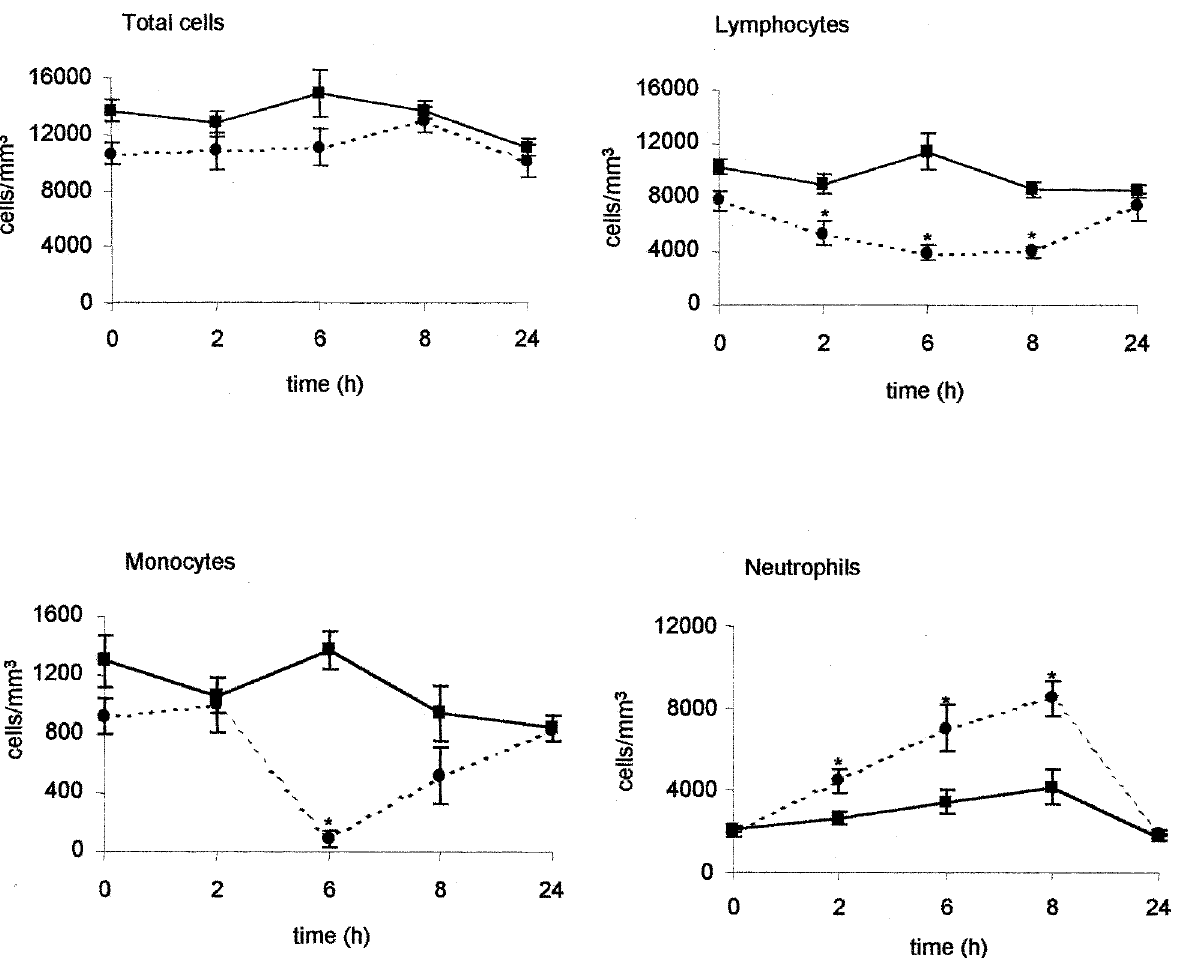
FIG. 1. Effect of crotoxin (CTX) on circulating leukocyte mobilisation. Blood was collected from orbital plexus of mice before or at different intervals of time after subcutaneous injection of 5 m g of CTX ( d ) or equivalent concentration of bovine serum albumin (BSA) ( j ) dissolved in 100 m l of sterile saline. Total leukocyte number was determined in a Neubauer haemocitometer, and lymphocyte, monocyte or neutrophil numbers were quantified in blood smears. Values represent the mean ± SEM of six animals in each group. * p < 0.01 in comparison with values obtained in BSA-treated